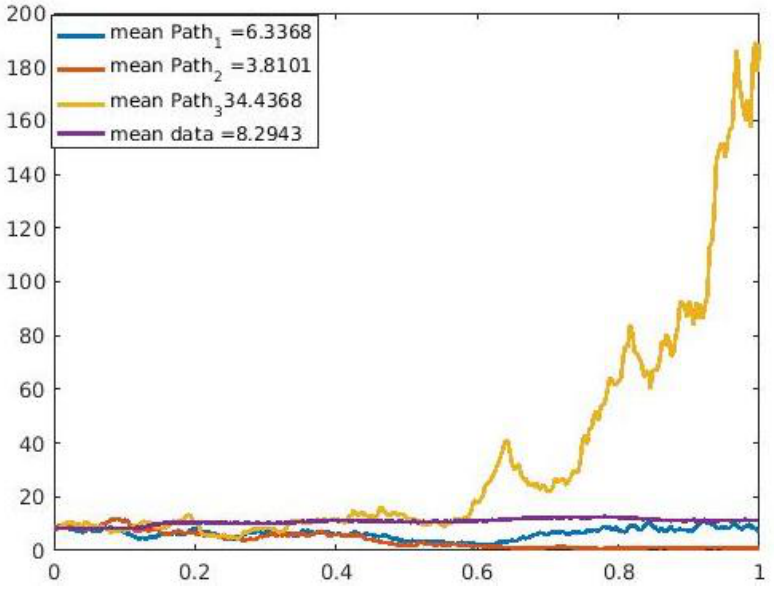
Figure 13. Graph showing three sample paths and time series plot for the U.S. COVID-19 cases. For this time series, we see that sample path 1 closely predicts it and by comparison of the means, sample path 1 is closer in value to the mean of the time series data.